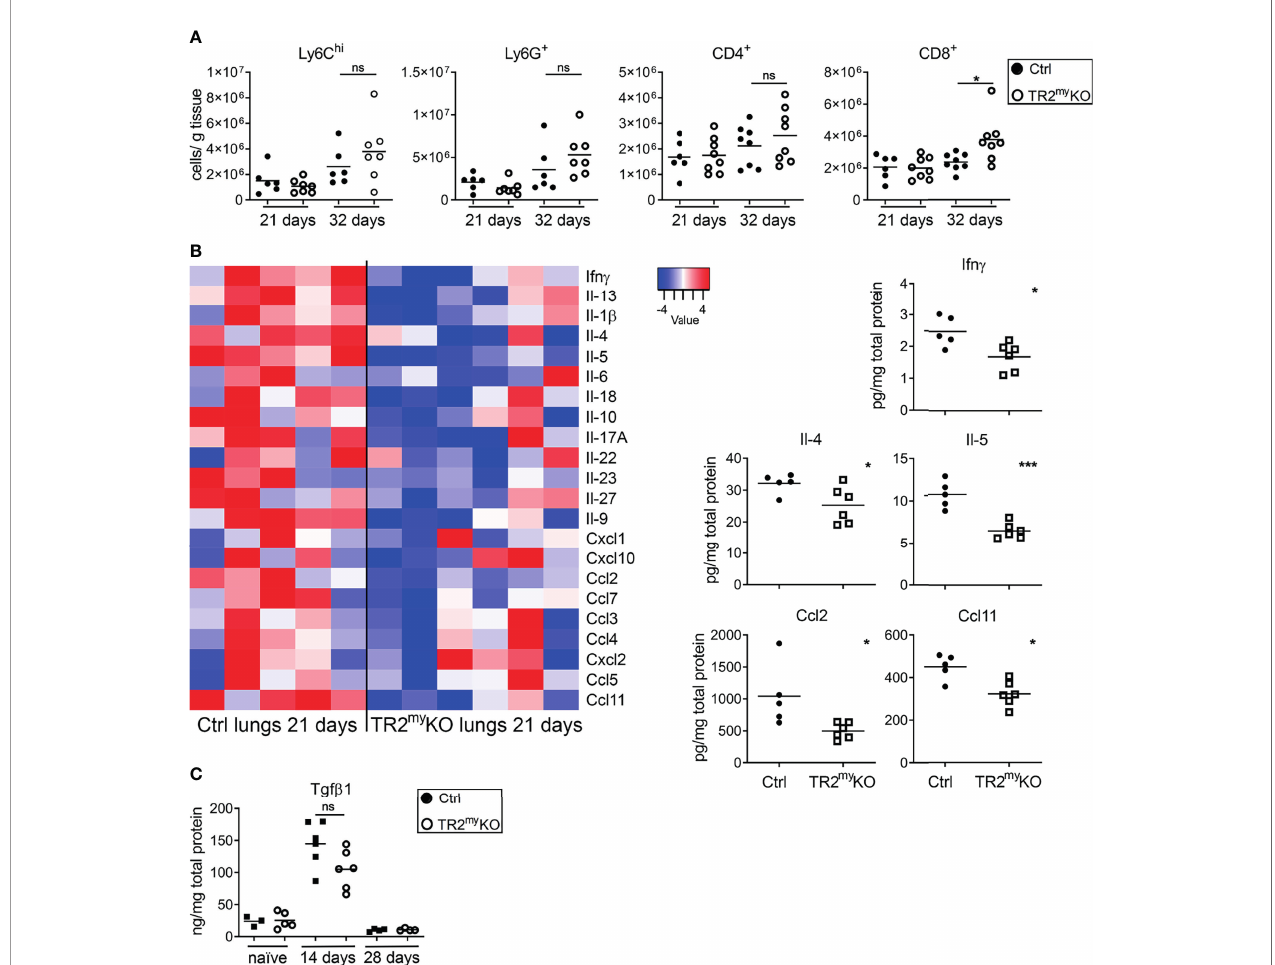
FIGURE 5 | Analysis of spontaneous lung metastasis in Tgfbr2 -myeloid cell-de fi cient mice. (A) Flow cytometry analysis of the myeloid cells, Ly6C hi , Ly6G + ; and lymphocytes, CD4 + and CD8 + cells in lungs at day 21 and 32 after the subcutaneous injection of LLC1.1 cells in TR2 myelo KO mice and Ctrl mice, respectively. (B) Determination of cytokine amounts in the perfused lung homogenates of TR2 my KO and Ctrl mice at day 21. Quanti fi cation of selected cytokines amounts (panels) with signi fi cant changes among TR2 my KO and Ctrl mice samples. (C) Tgf b 1 levels in the lungs of tumor-bearing mice at day 14 and 28 after subcutaneous injection of LLC1.1 cells, when compared to naïve mice. Statistical signi fi cance was assessed using Mann-Whitney test: ns, not signi fi cant; *p < 0.05; ***p <